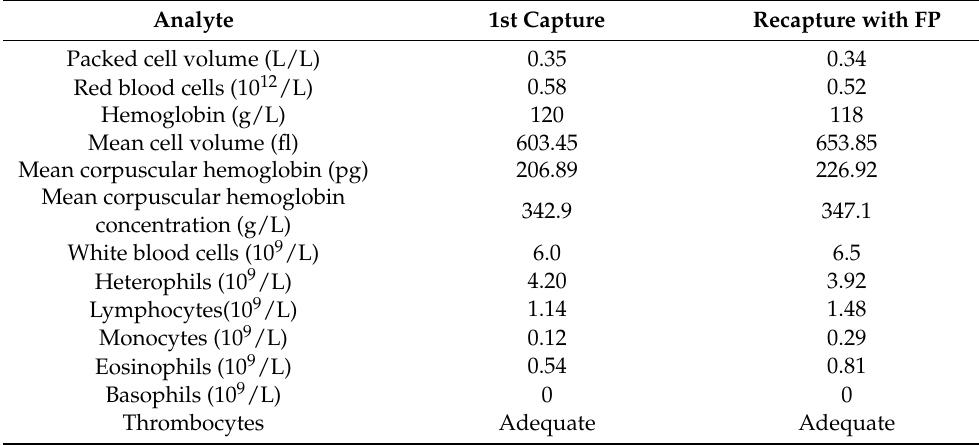
Table 1. Hematological values of the black turtle ( Chelonia mydas ) from first capture and recapture (eleven months after) when the turtle presented fibropapillomatosis